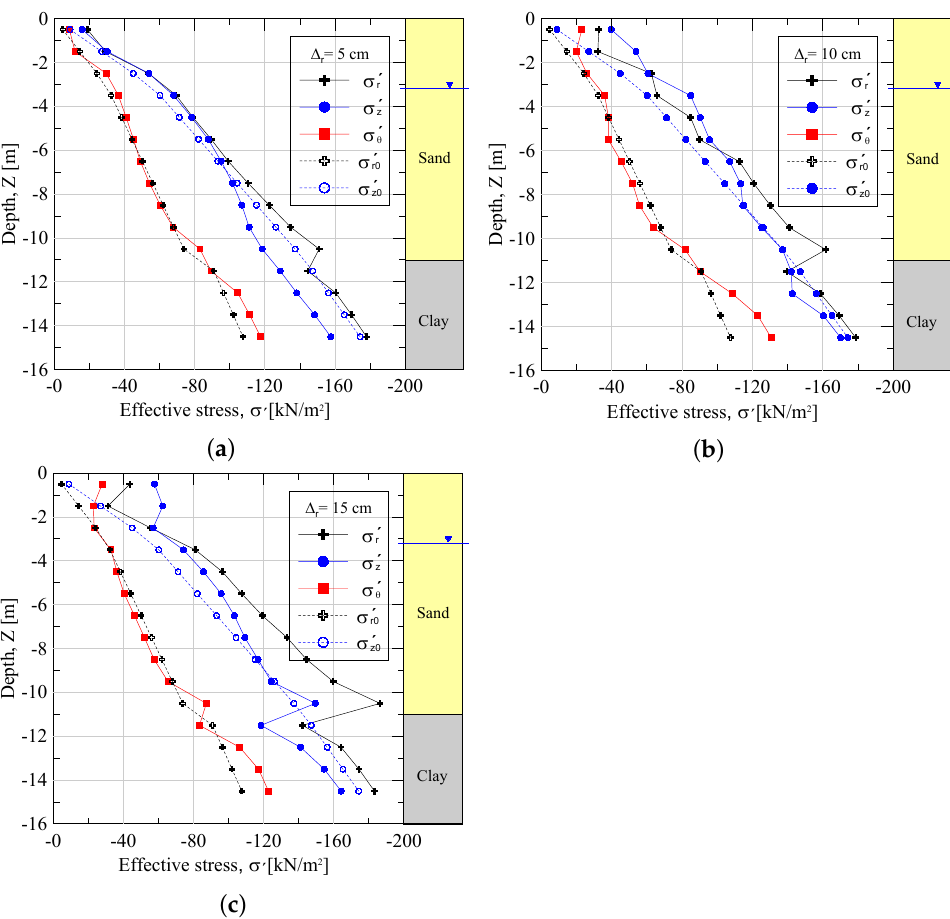
Figure 10. Stress distributions for different displacements at the distance of r c from the column center with depths. ( a ) ∆ r = 15 cm ( b ), ∆ r = 10 cm, and ( c ) ∆ r = 15 cm. The earth pressure coefficient is utilized to be the function that represents the change in the stresses after the installation in the surrounding area. Figure 11a,b depict the variation of K r after consolidation in two different layers with the normalized distance to the column axis. The stress distribution is revealed by the radial earth pressure coefficients K r :